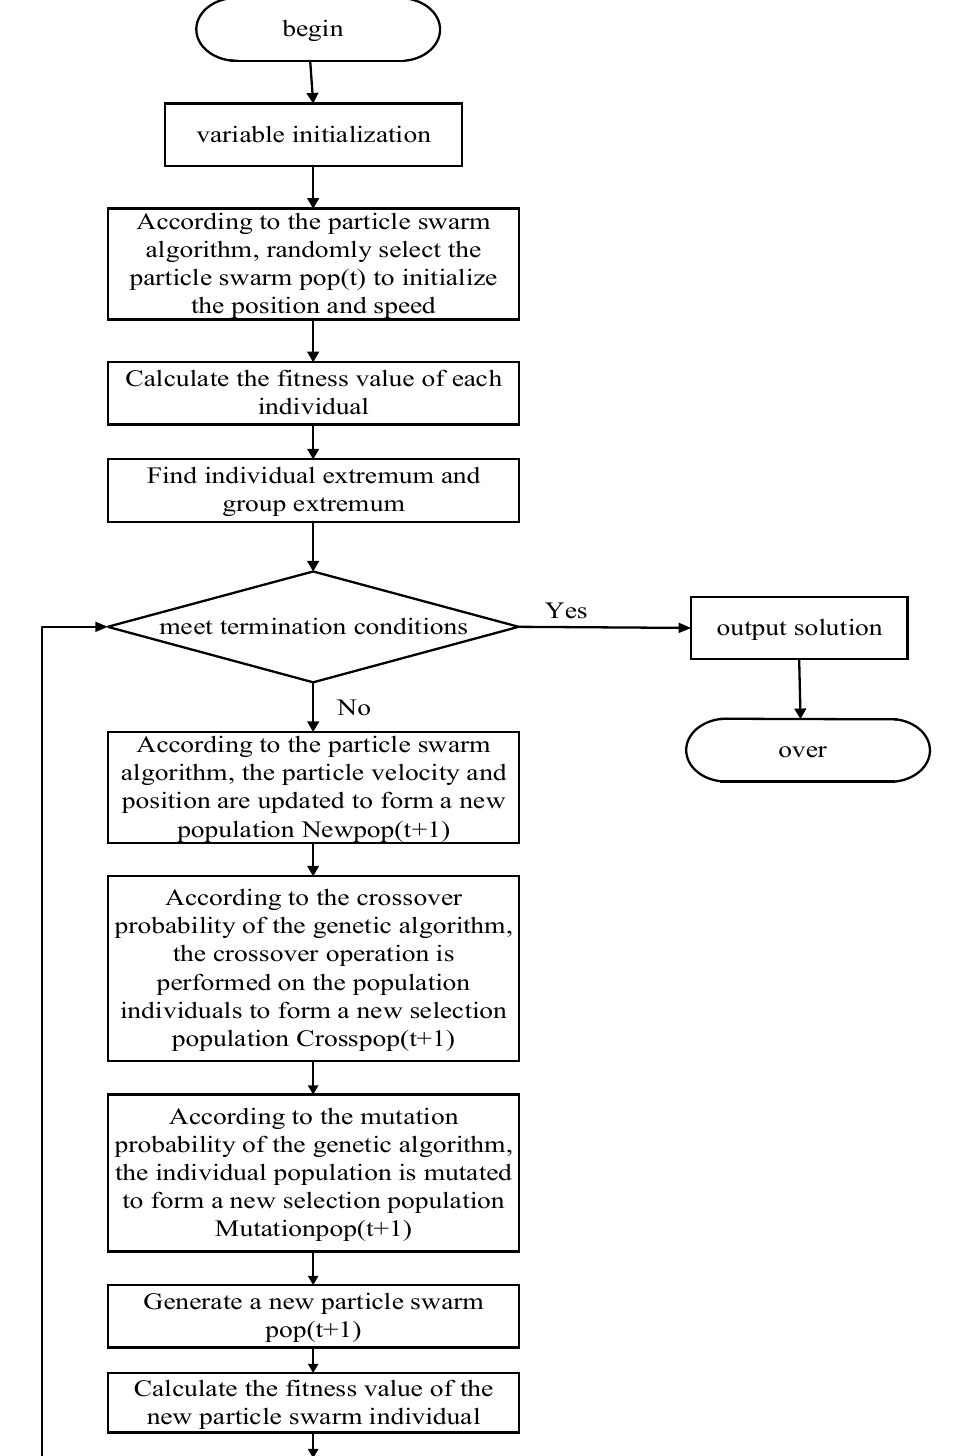
Figure 12. Flowchart of the GA-PSO hybrid optimization algorithm.